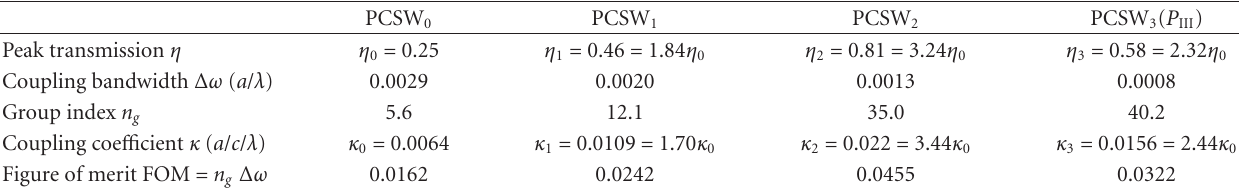
Figure of merit FOM = n g Δ